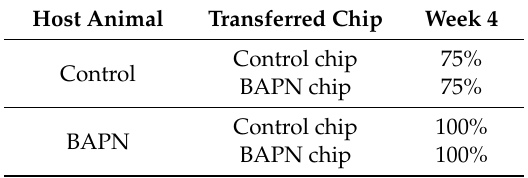
Table 1. Ratio of union to non-union between transferred bone and host